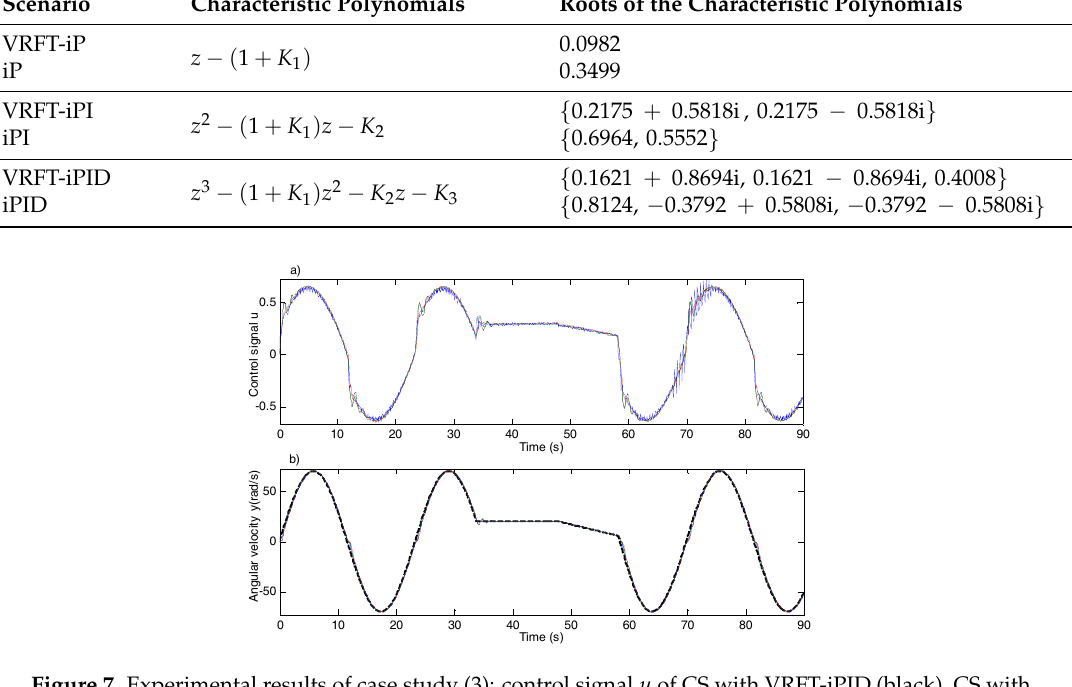
Figure 7. Experimental results of case study (3): control signal u of CS with VRFT-iPID (black), CS with iPID (red), CS with VRFT-PID (green), and CS with PID (blue) controllers in ( a ); reference trajectory y d (solid black dashed), controlled output y of CS with VRFT-iPID (black), CS with iPID (red), CS with VRFT-PID (green), and CS with PID (blue) controllers in ( b ).